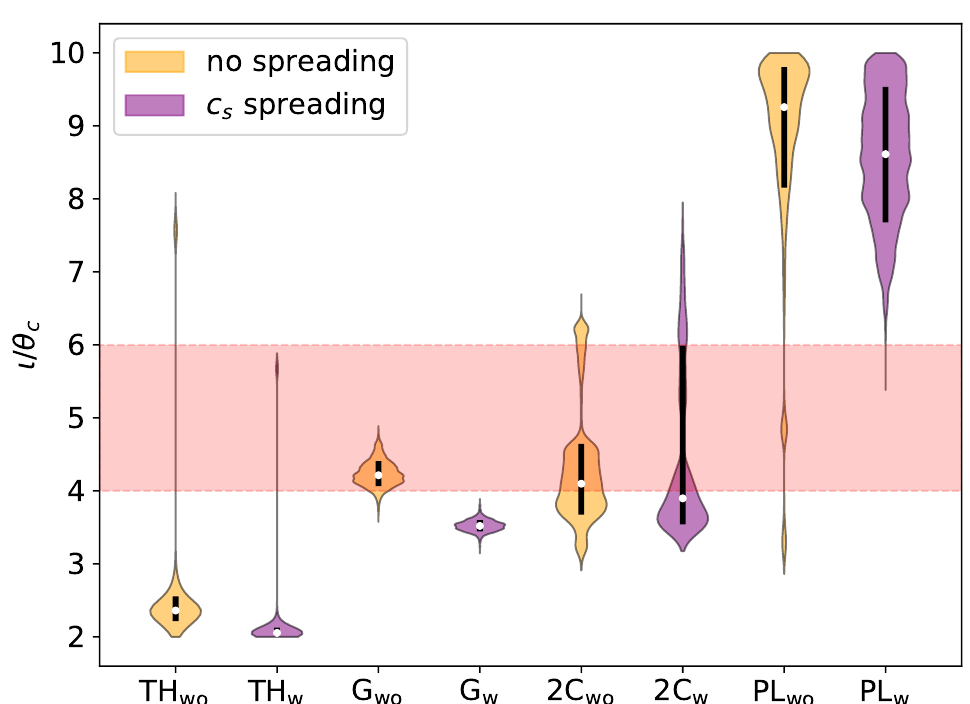
Figure 5. The posterior distribution from MCMC fits of our four fiducial jet structure models to GW170817 late-time afterglow data with no lateral spreading (orange) and maximal lateral spreading (purple). The white dot and the thick black lines show the central and the 16th and 84th percentile values for the distribution. The horizontal width is indicative of the probability distribution in ι / θ c for each model. The expected ratio for consistency with VLBI observations of superluminal motion are 4 (cid:46) ι / θ c (cid:46) 6 [31], red band, and where values of ι / θ c < 6 can give a reasonable approximation for the real observation angle when inferred from superluminal motion measurements via the point approximation